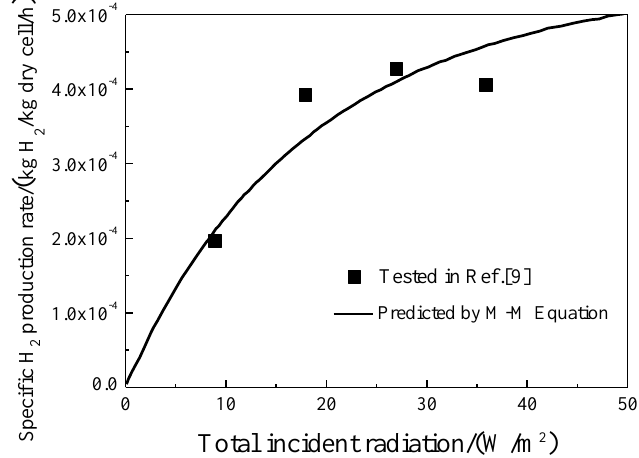
Figure 2. Hydrogen production simulation of C. reinhardtii GY-D55 by the Michaelis-Menten equation was compared with an experiment illuminated with a blue light emitting diode (LED) lamp [9].